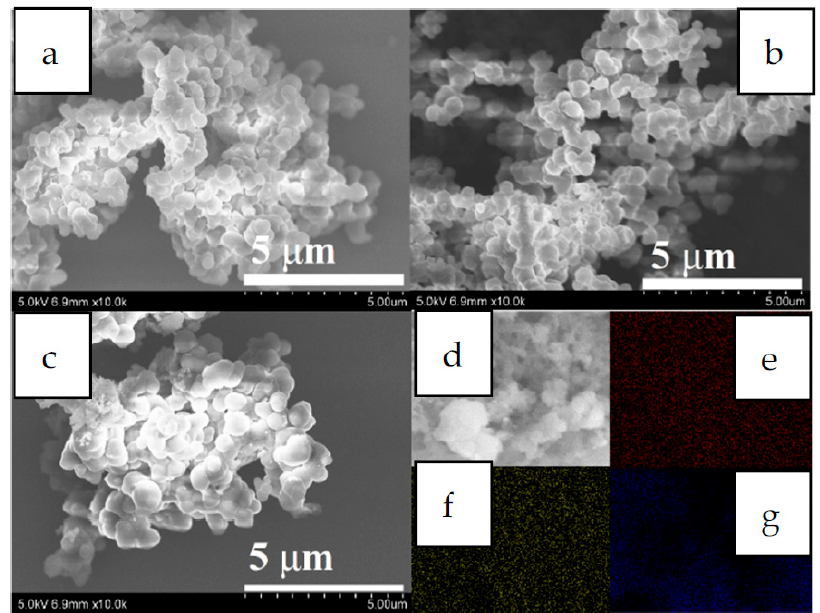
Figure 5. SEM mages of CuPBr-COF ( a ), CuPCl-COF ( b ) and Br-COF ( c ), and elemental mapping of CuPBr-COF (( d ), SEM, ( e ), C, ( f ), N, ( g ),